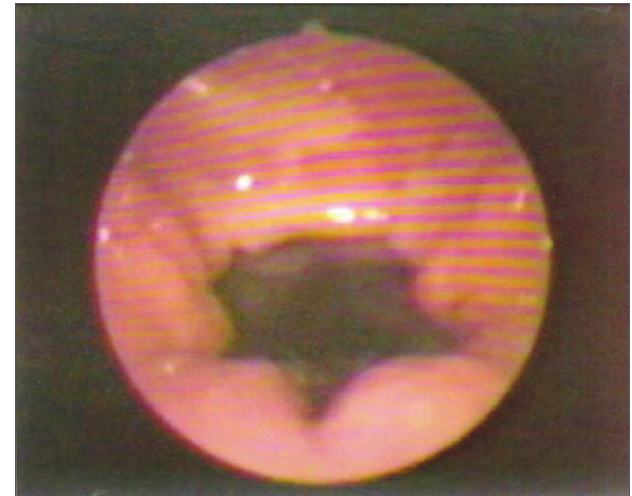
Figura 2. Paciente 1: fechamento do EVF em registro basal